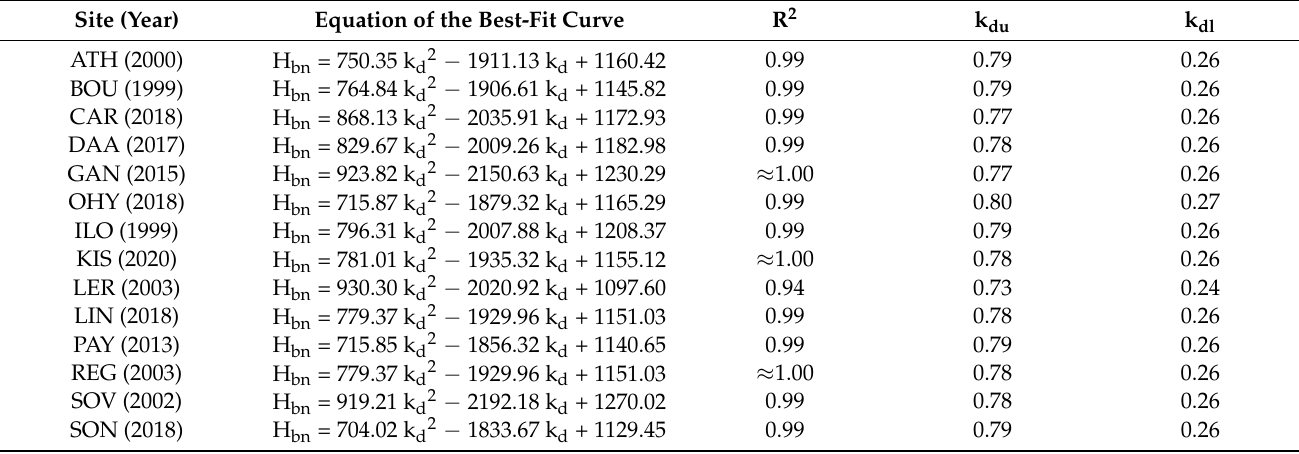
Table 2. Second-order polynomial expression for the function H bn vs. k d with R 2 , k du , and k dl values. All values have been rounded to the second decimal digit. The year in parenthesis in column 1 denotes the period of the downloaded solar radiation measurements from the BSRN sites. The criterion for the year selection was to be outside the PV-GIS TMY period of 2004–2015, if possible.